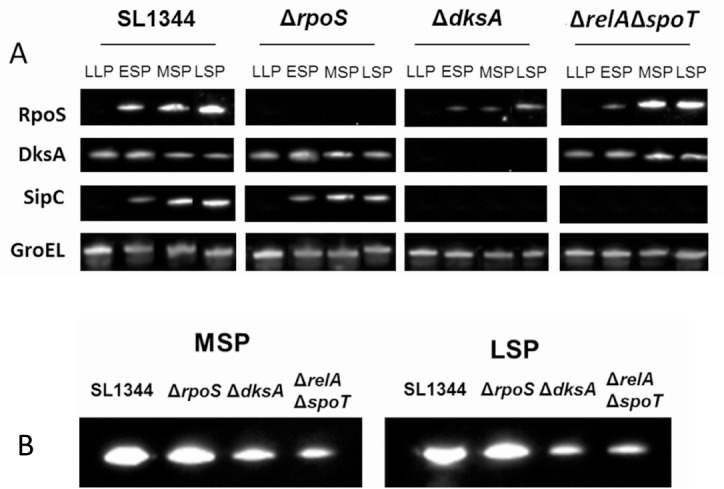
(A) western blot showing intracellular levels of RpoS, DksA, SipC and GroEL (loading control) at LLP, ESP, MSP and LSP in parental (SL1344), ΔrpoS, ΔdksA and ppGpp0 (ΔrelAΔspoT) strains. (B) western blot showing SipC levels in culture supernatants from parental, ΔrpoS, ΔdksA and ΔrelAΔspoT strains during mid stationary phase (MSP) and late stationary phase (LSP).